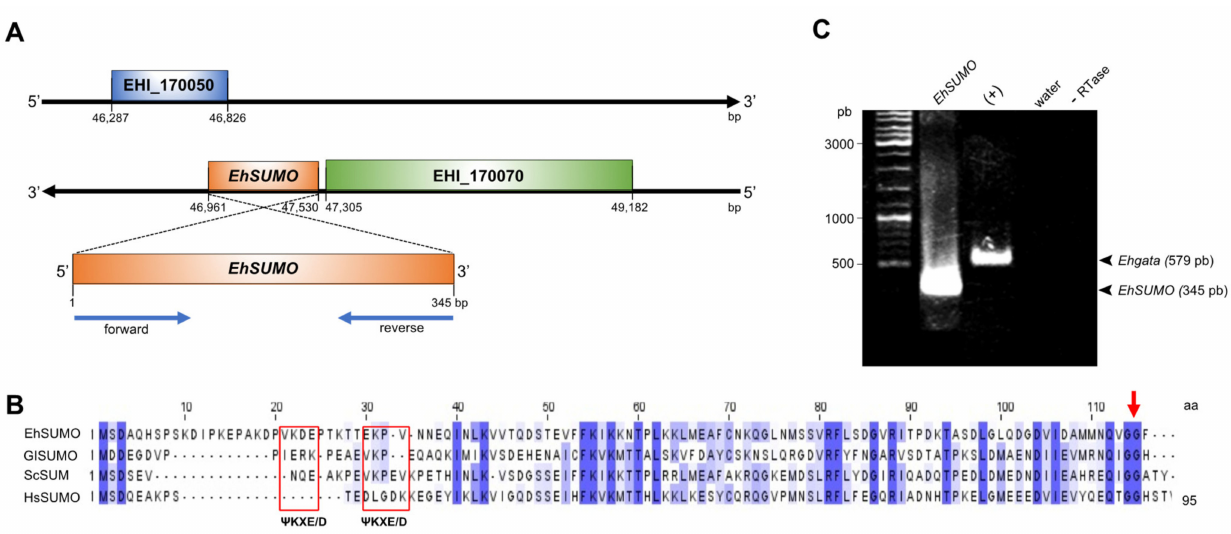
Figure 1. Identification and location of the EhSUMO gene in E. histolytica genome . ( A ) Location of EhSUMO gene in the genome. EhSUMO is in a contig located between 47,530 to 46,961 bp in the DNA negative chain flanked by two hypothetic genes (EHI_170050 and EHI_170070). Blue arrows: primer designed for EhSUMO amplification. ( B ) Comparative alignment of predicted EhSUMO amino acid sequence with proteins from other organisms, the blue color indicates the identity and similarity of amino acids. Red squares signal the Ψ KXE/D motifs and arrow the GG doublet. ( C ) PCR amplification using complementary DNA (cDNA) as a template and specific primers for EhSUMO. Ehgata : positive control (+). Negative controls: in the mixture instead of template water was added or in the cDNA production, the RTase was omitted (-RTase). Arrowheads: PCR products.